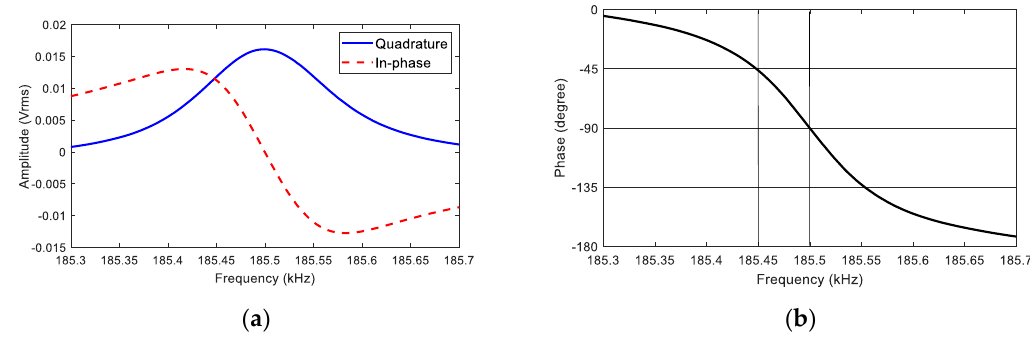
Figure 2. Measured line shapes. ( a ) Magnetic resonance signal line shapes. ( b ) Phase line shape.